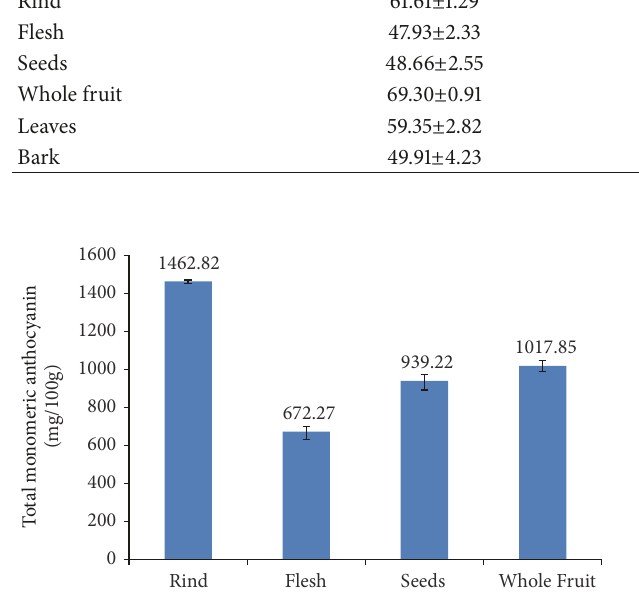
Figure 3: Total anthocyanin of L. alata